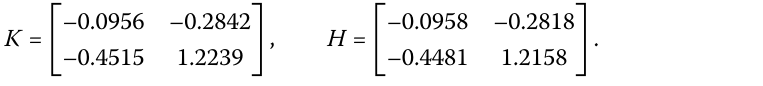
Time-varying delays of system (33) are satisfied with 1 < d 1 ( t j ) < 24 and 1 < d 2 ( t i ) < 11. Sampling periods of system (33) are chosen as T v = 0.1 and T h = 0.02. Letting parameters τ τ τ τ τ 1 = 0.01, 2 = 0.02, 3 = 0.03, 4 = 0.03, and 5 = 0.95. By solving the optimization problem (30), matrices K and H are obtained